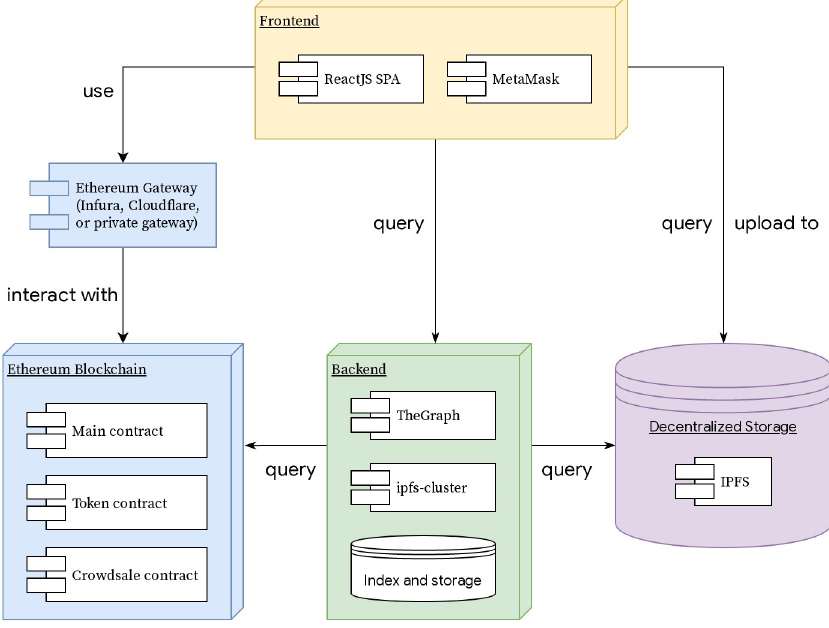
Fig 4. Technologies and tools. Enabling technologies and tools associated with the AnyCase ecosystem